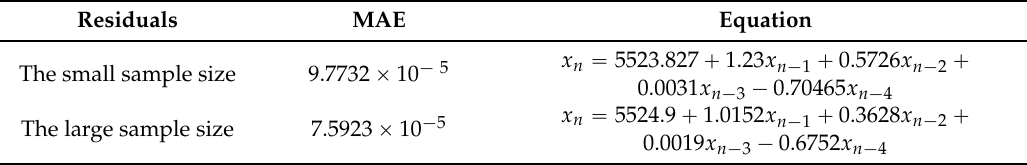
Table 3. Summary of results of the AR forecasting model for data-II.